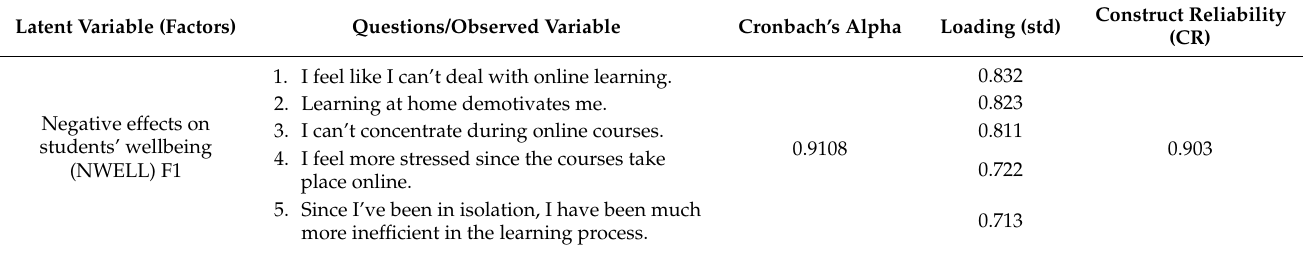
Table 2. The values of the Cronbach’s alpha index for the analysed factors and the variable validity testing. Latent Variable